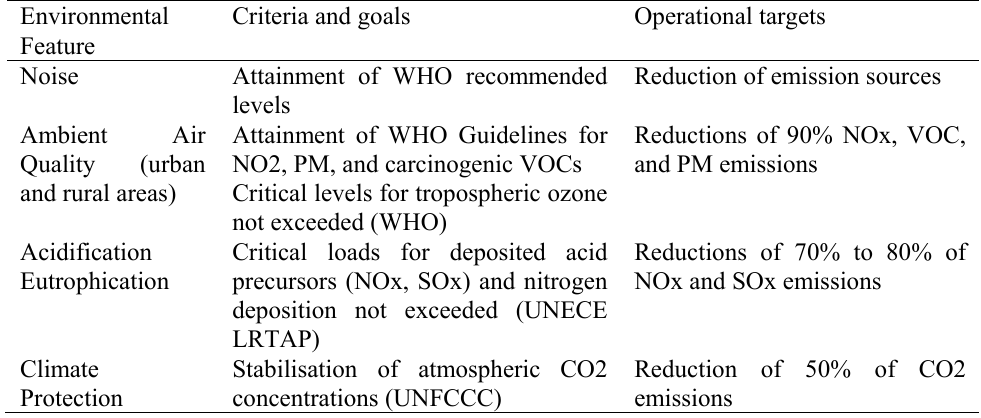
Table 2: Quantification of environmental criteria for EST